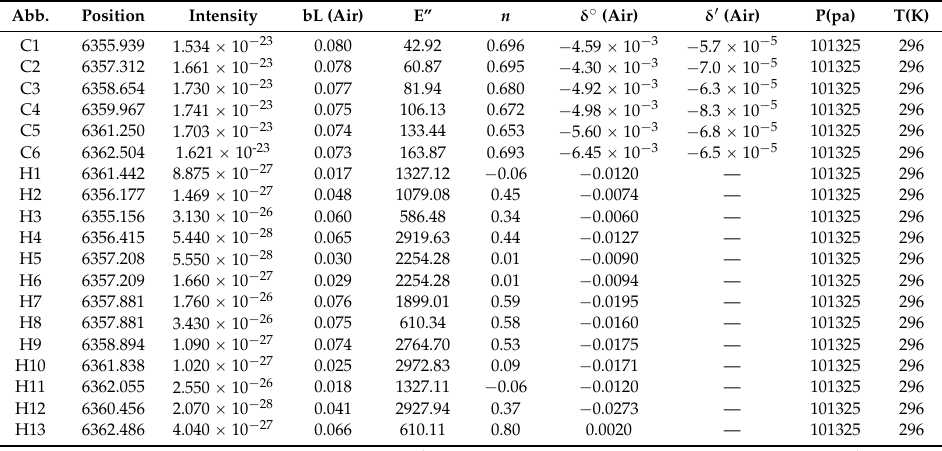
Figure 2. Calculated absorption cross sections of CO 2 and H 2 O based on HITRAN 2012 and HITEMP 2010. Table 1. Spectroscopic parameters of CO 2 and H 2 O involved in the simulation analysis.